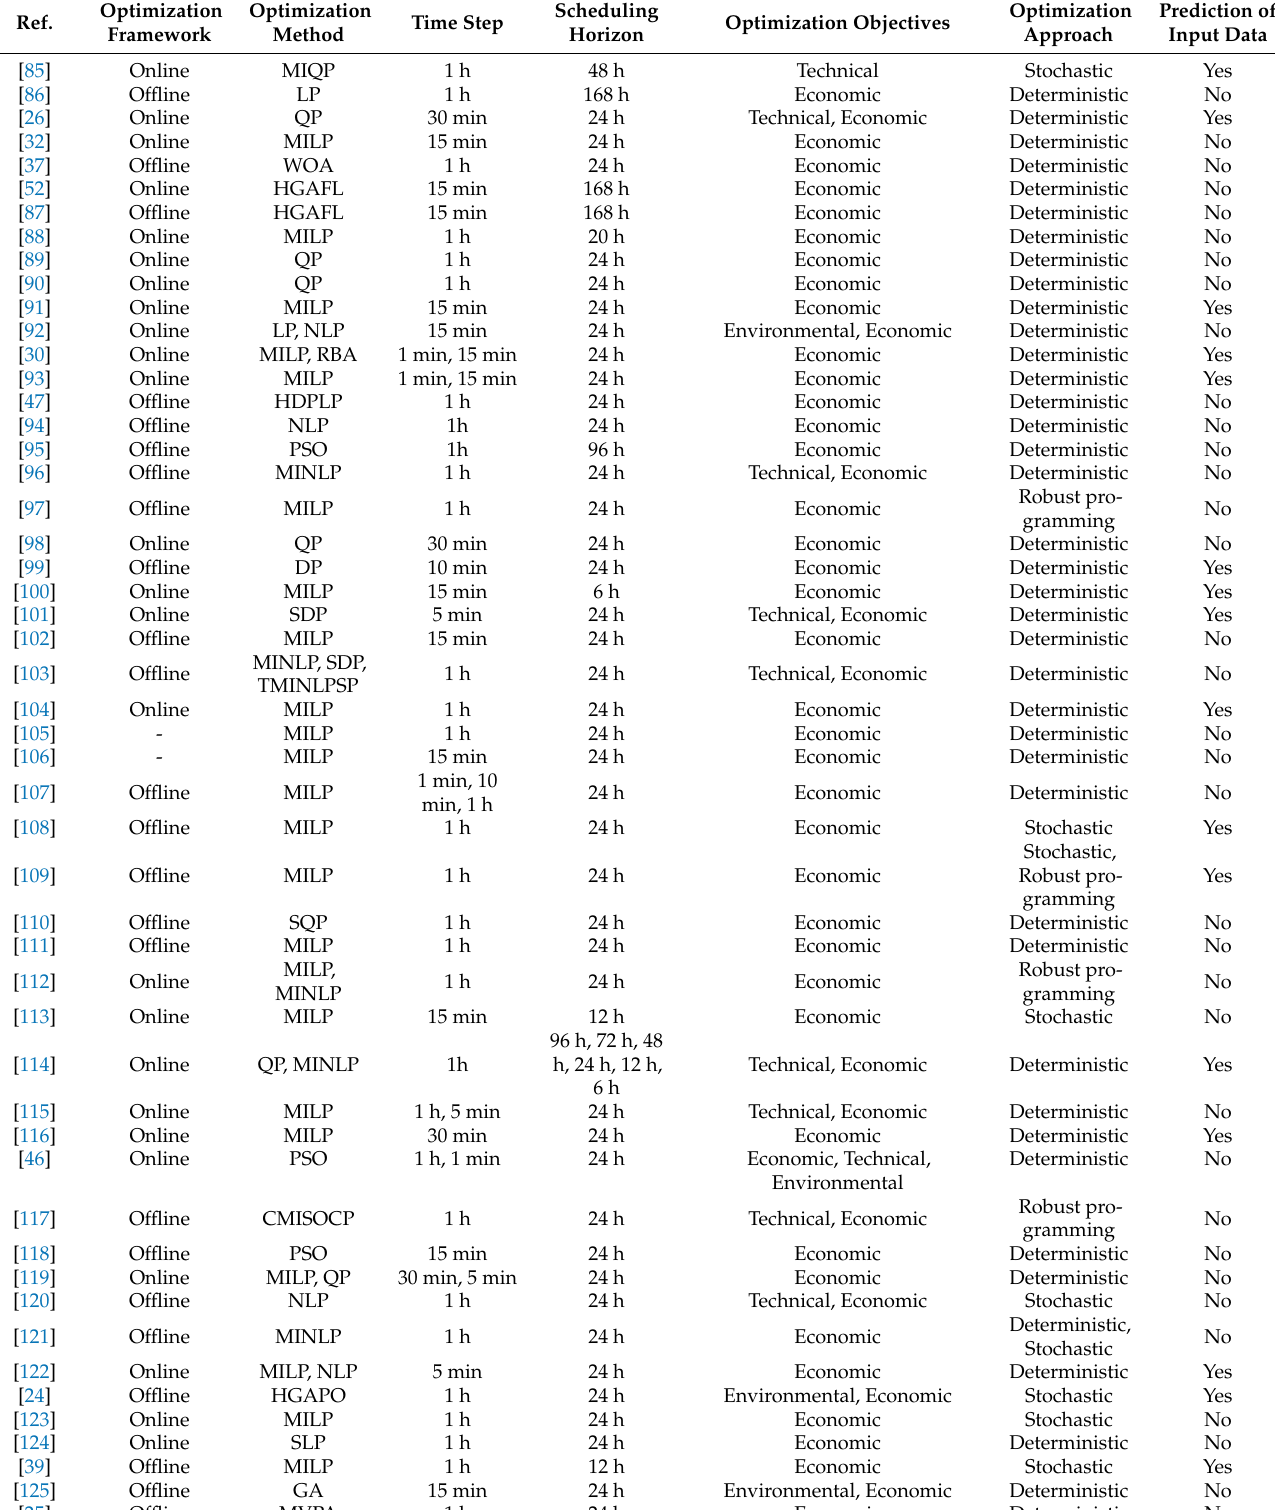
Table 2. Review of the scientific literature with respect to the optimization framework, optimization method, optimization approach, objective function and other specificities of the optimization problem.